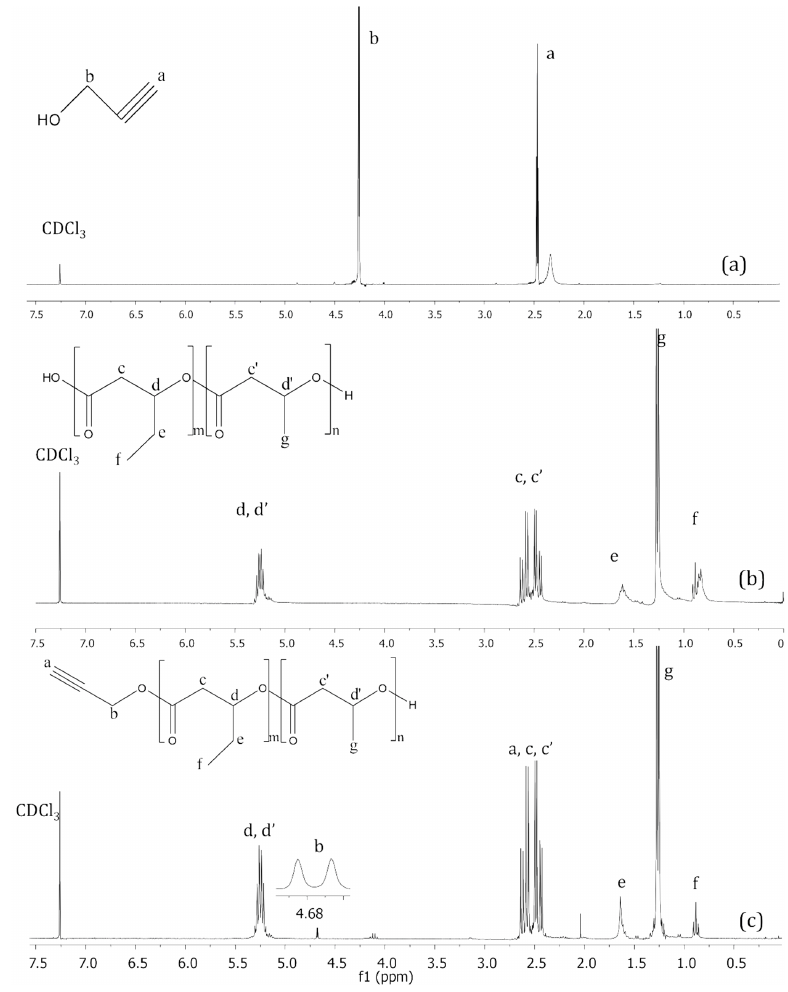
Figure 2. 300 MHz 1 H NMR spectra of propargyl alcohol ( a ), unmodified PHBHV ( b ) and PHBHV- Figure2. 300MHz 1 HNMRspectraofpropargylalcohol( a ), unmodifiedPHBHV( b )andPHBHV-alkyne alkyne after transesterification with propargyl alcohol ( c ) in CDCl 3 . after transesterification with propargyl alcohol ( c ) in CDCl 3 Table 1. Number average molar masses ( Mn ) and dispersity ( Đ ) of unmodified PHBHV and PHBHV- alkyne. Sample